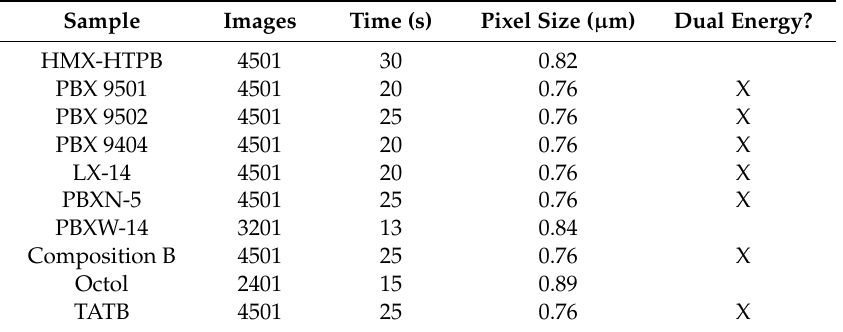
Table 2. Imaging conditions used for the high resolution images of the pressed